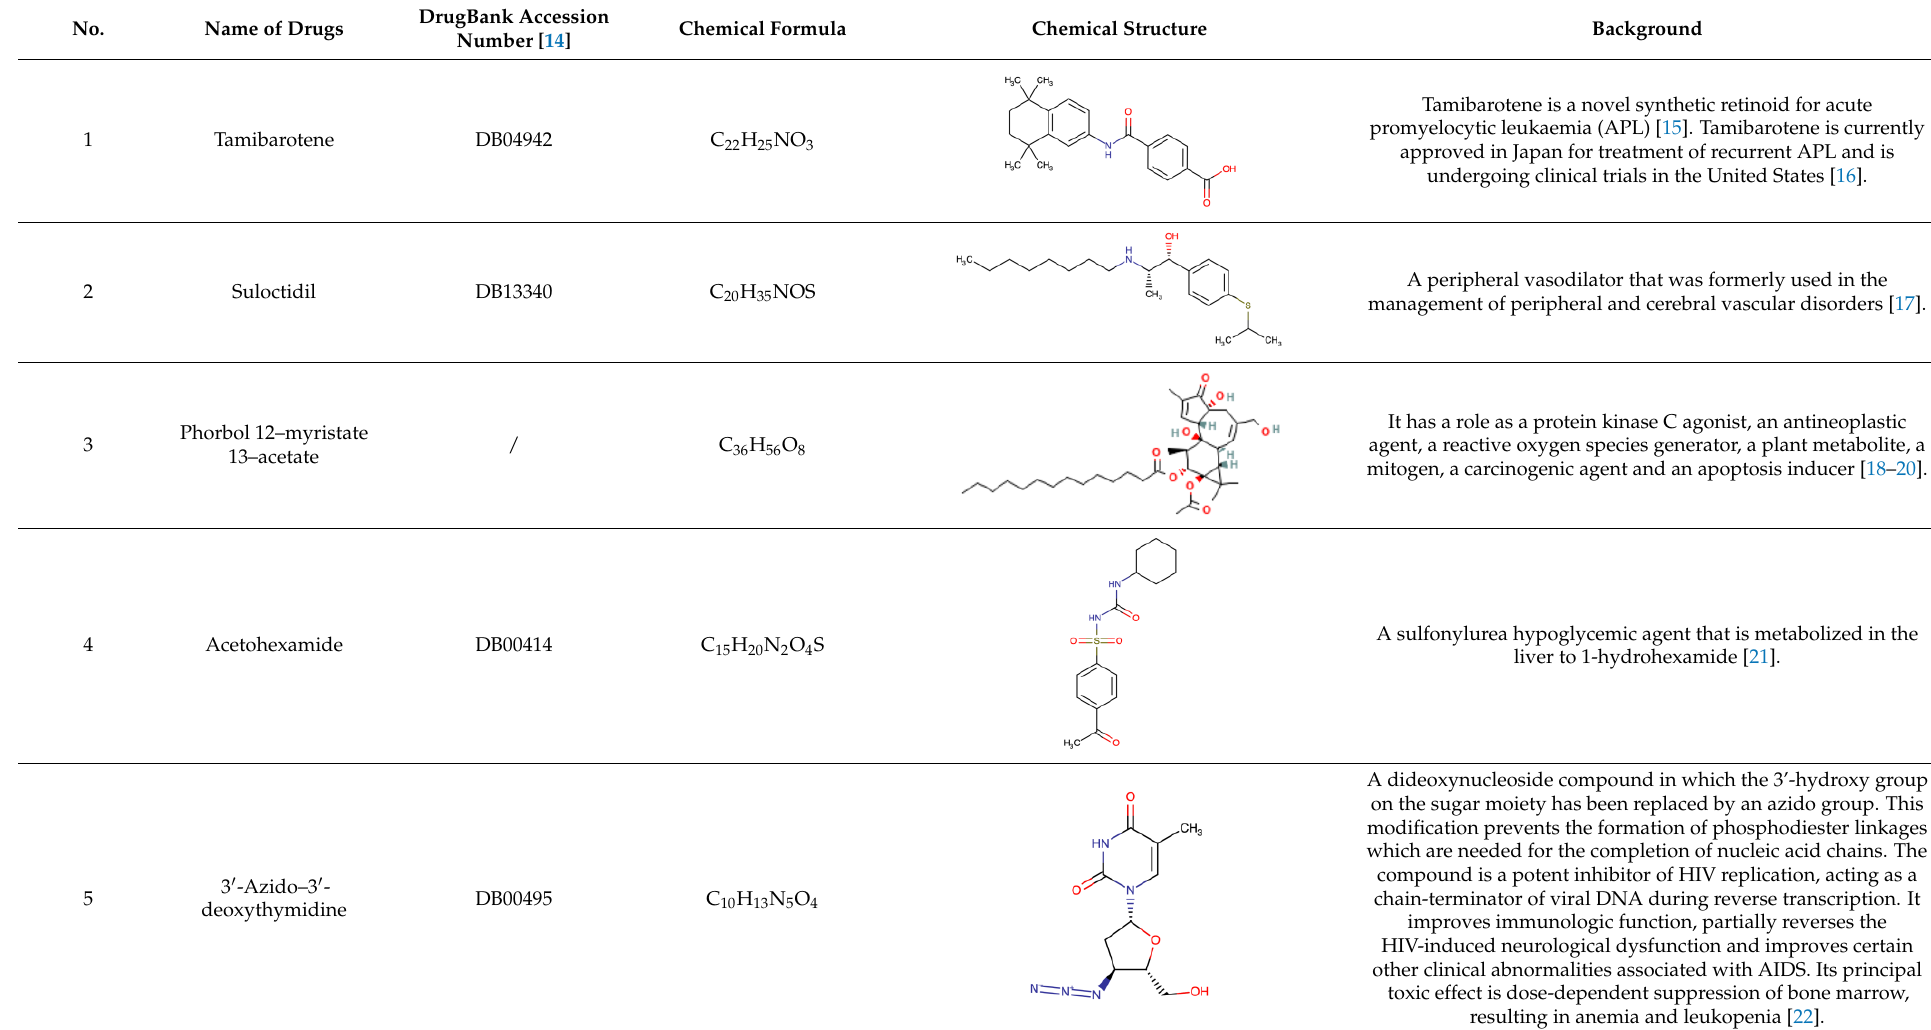
Table 1. Suggested TOP 5 drug compounds.